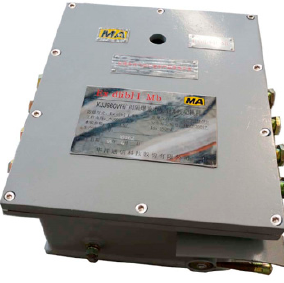
Figure 2. The image of the AP device KJJ660W used in the coal mine.